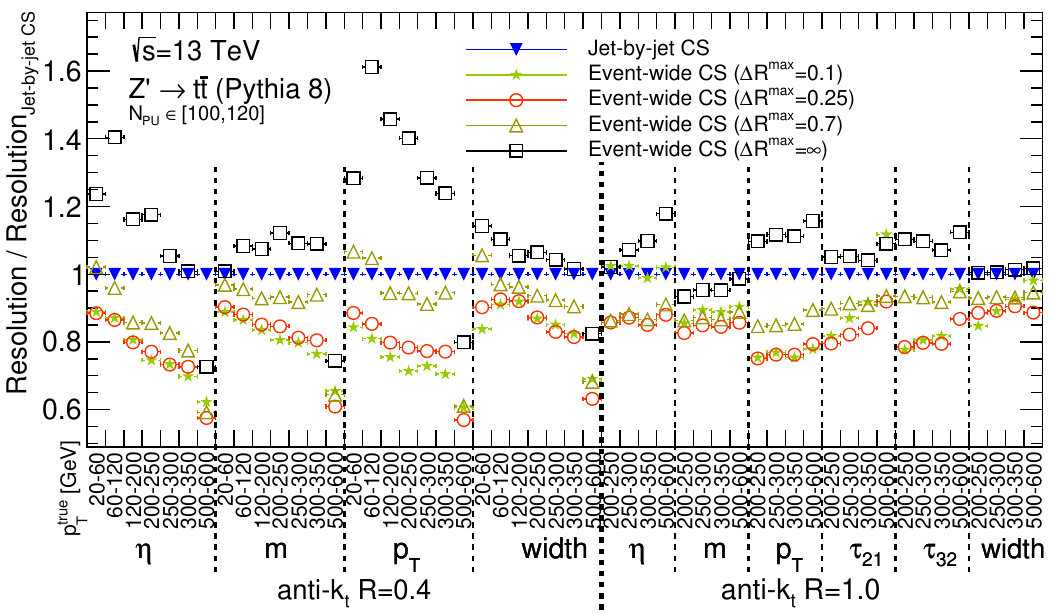
Figure 13. Dependence of resolution on the (cid:1) R max parameter for the Event-wide CS. The other CS parameters are (cid:11) = 0 and A g = 0 :